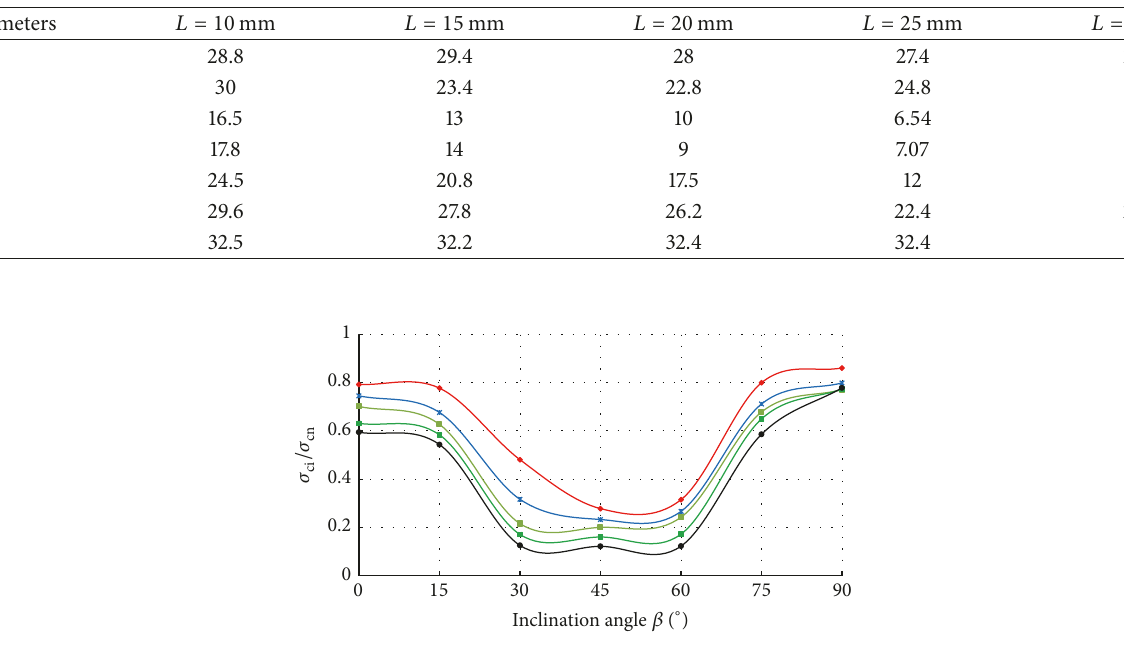
Table 4: The CD stress 𝜎 cd versus flaw inclination angle 𝛽 and length 𝐿 .